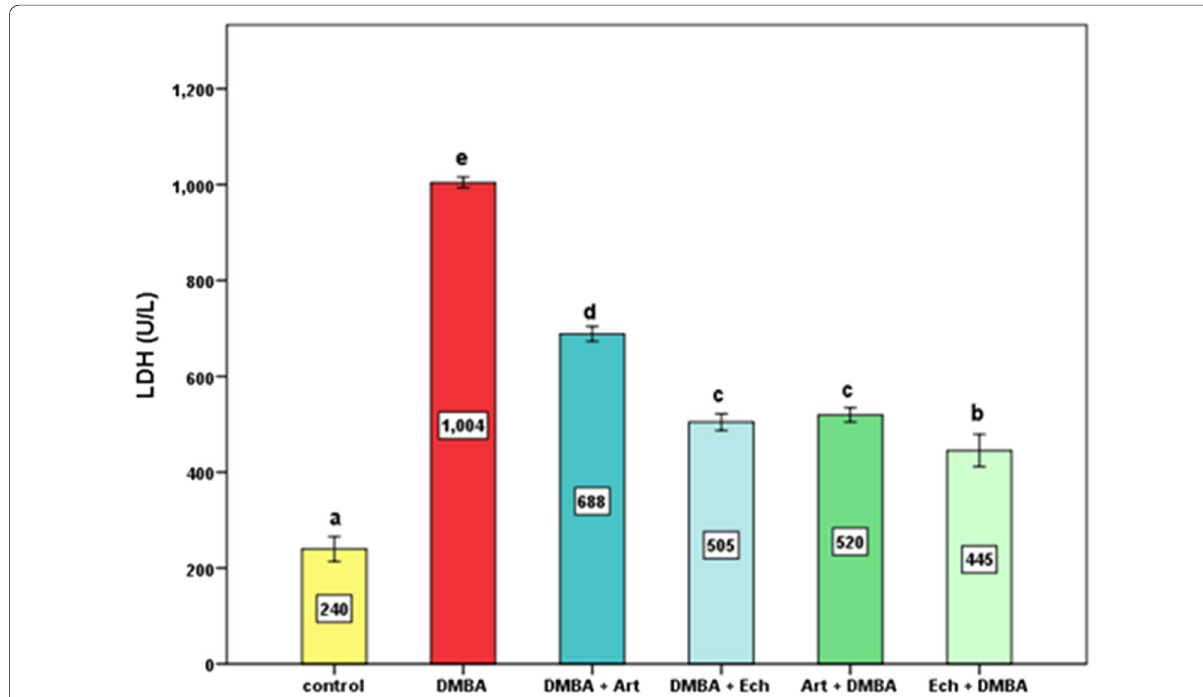
Fig. 3 Effect of treatment or protection with Artemisia or Echinacea on serum lactate dehydrogenase (LDH) activity (U ∕ L) in DMBA‑administered rats of all experimental groups. Values with different letters above columns are considered significantly different ( P ˂ 0.05). Values with same letters above columns are considered non‑significantly different ( P ˂